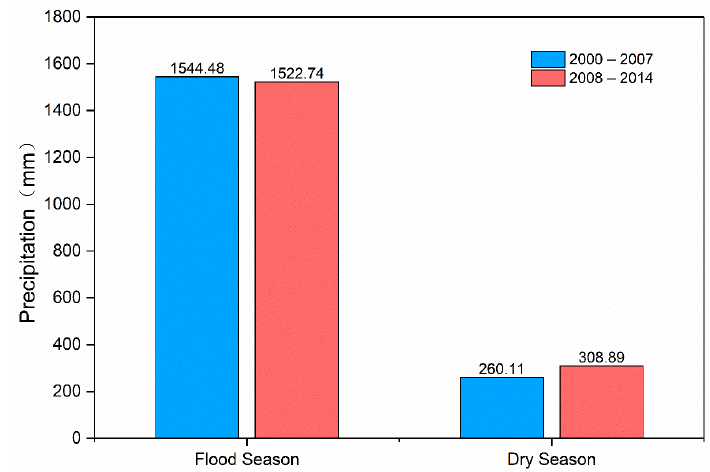
Figure 8. Comparison of the Average Precipitation in the Flood Season and Dry Season before and after 2008.